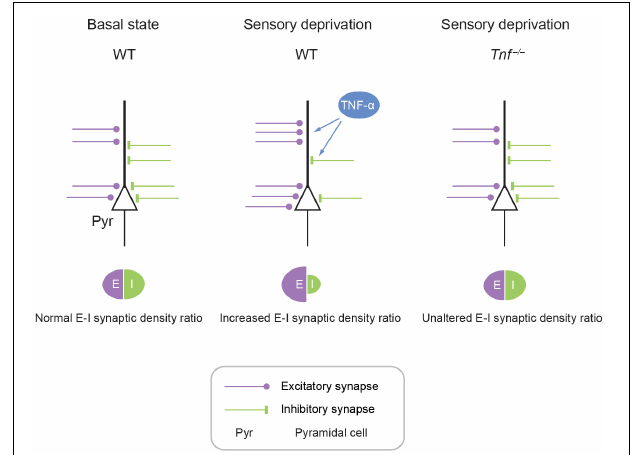
FIGURE 5 | Schematic model showing TNF- α mediates experience-dependent modulation of synaptic plasticity of structural excitatory-inhibitory ratio in APC. In the APC, E-I synaptic density ratio is determined by local neural activity, which in turn is primarily determined by the upstream activity in the OB. Fluctuating activity levels induce plasticity in the APC. For example, hypo-activity in the form of sensory deprivation can increase excitation while decreasing inhibition, achieving an enhancement of E-I synaptic density ratio. This augmentation of E-I synaptic density ratio is mediated by astrocytic TNF- α , as evidenced by the complete abolishment of this plasticity in the Tnf − / −